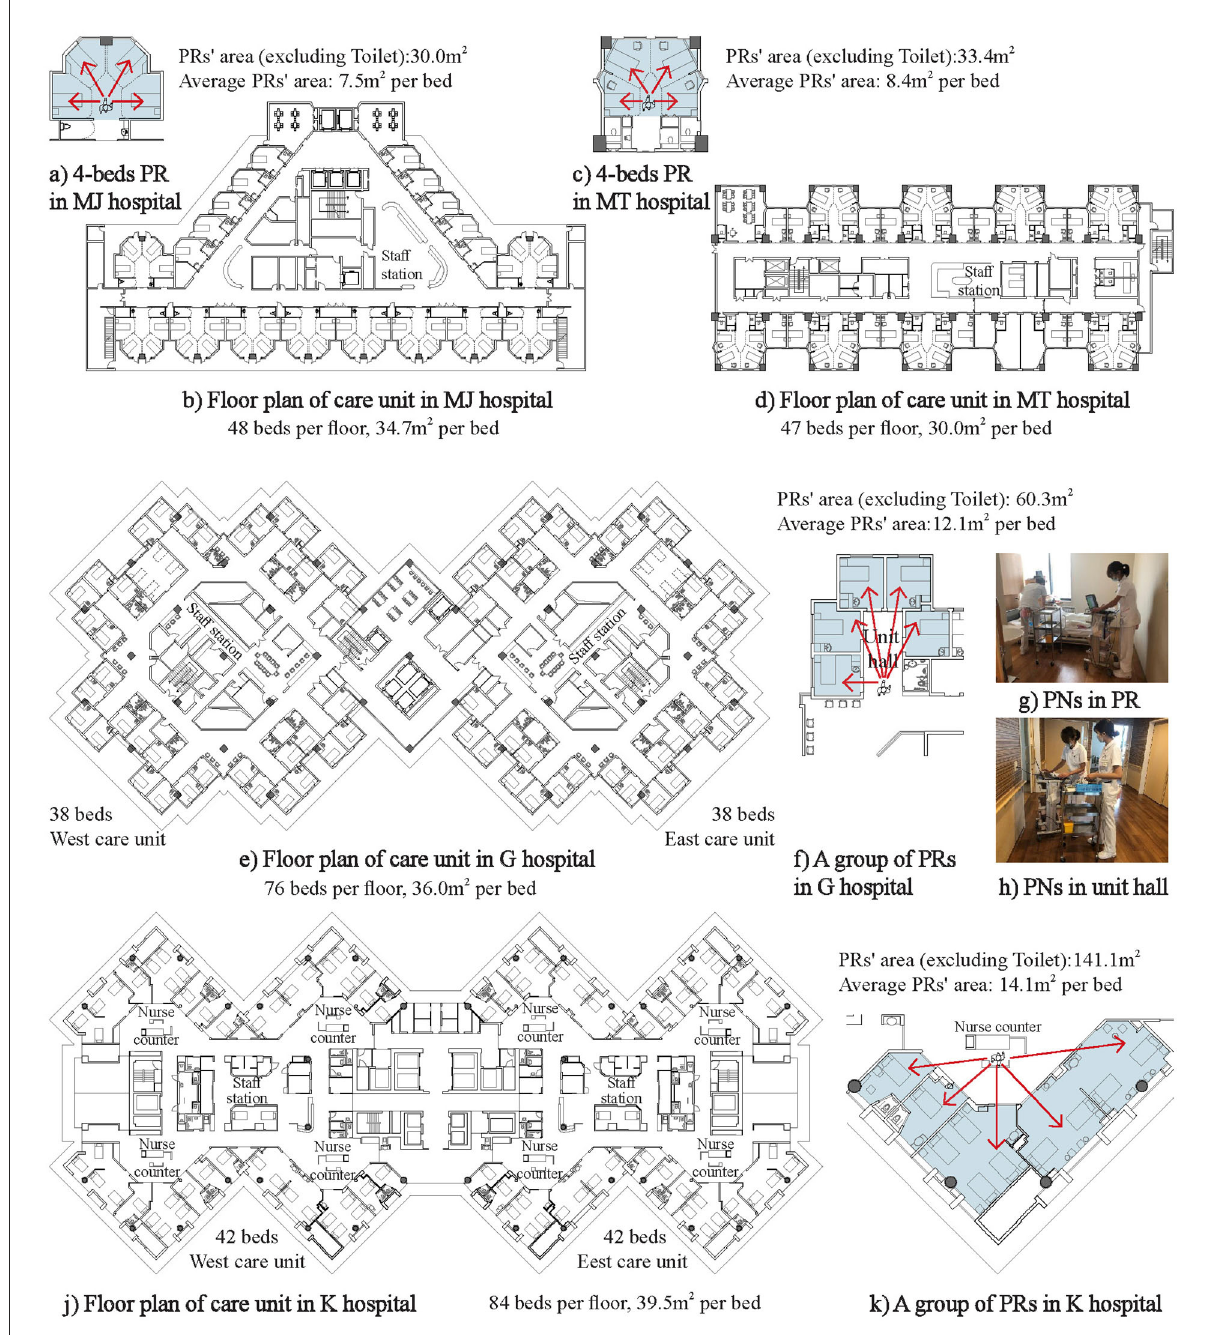
FIGURE6 Typical patient rooms in Japan. (A) 4-beds PR in MJ hospitalin hospital PRs’ area (excluding Toilet):30.0m 2 , Average PRs’ area: 7.5m 2 per bed. (B) Floor plan of care unit in MJ hospital 48 beds per floor, 34.7m 2 per bed. (C) 4-beds PR in MT hospital PRs’ area (excluding Toilet):33.4m 2 Average PRs’ area: 8.4m 2 per bed. (D) Floor plan of care unit in MT hospital 47 beds per floor, 30.0m 2 per bed. (E) Floor plan of care unit in G hospital 38 beds West care unit 38 beds East care unit 76 beds per floor, 36.0m 2 per bed. (F) A group of PRs in G hospital PRs’ area (excluding Toilet): 60.3m 2 Average PRs’ area:12.1m 2 per bed (G) PNs in PR. (H) PNs in unit hall. (J) Floor plan of care unit in K hospital.84 beds per floor, 39.5m 2 per bed 42 beds West care unit 42 beds East care unit (K) A group of PRs in K hospital PRs’ area (excluding Toilet):141.1m 2 Average PRs’ area: 14.1m 2 per